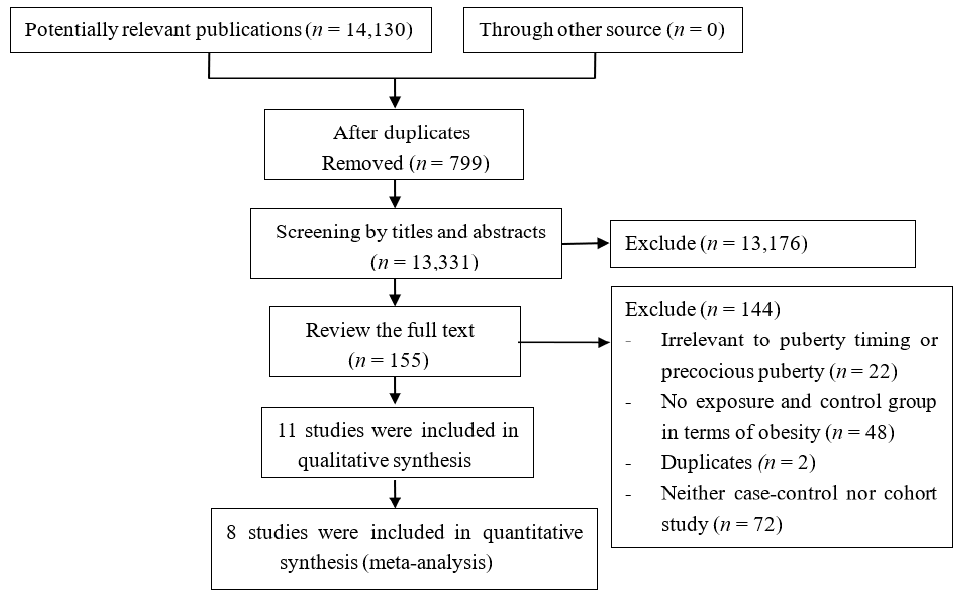
Figure 1. Flow diagram of the literature search.